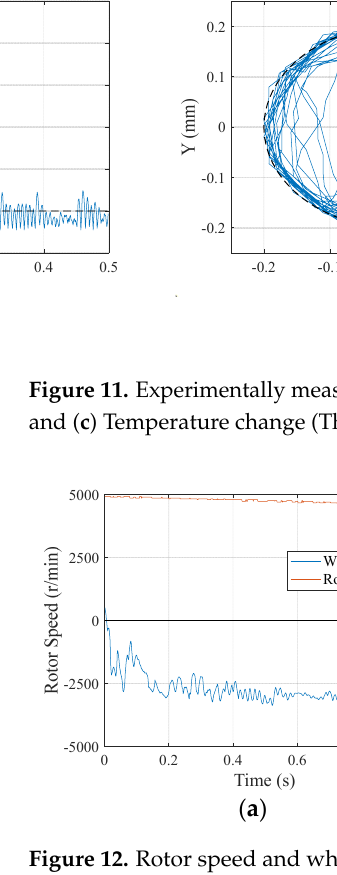
( b ) Figure 13. Rotor speed and whirl speed measured in the 20,000 r/min drop test: ( a ) First second, ( b ) Whole process. At a 5000 r/min drop in Figure 12, the rotor quickly entered a full-rub whirl state. Compared to the simulation results, the rotor experienced a longer period of backward whirl and entered a forward dry-friction whirl state, then decelerated to zero velocity syn- chronously as in the simulation. At a 20,000 r/min drop in Figure 13, the rotor moved more quickly from the backward whirl into the forward whirl than at the 5000 r/min drop. Then, the rotor remained at a whirl speed of 6174 r/min, resulting in a dry-friction whip state. After the speed was greatly reduced, the whirl speed also gradually decreased synchro- nously with the rotor, changing from dry-friction whip to dry-friction whirl. The maxi- mum temperature of the rolling body measured by the thermal imaging camera was 1.5 °C at 5000 r/min and 9.5 °C at 20,000 r/min above the ambient temperature, which were slightly lower than the simulation results, 2.4 °C at 5000 r/min and 10.5 °C at 20,000 r/min. Based on a comparison of the simulation and experimental results from Figures 7, 9, and 11–13, the results are in good agreement, especially the occurrence of each state in the whole rotor drop process, which was accurately predicted. In addition, comparing the deceleration of the rotor in Figure 14 proved the computational validity of the simulation model throughout the whole drop process, indicating that the simulation model could accurately evaluate the process of drop energy conversion, which basically met the re- search needs to study the contact force and heat generation.